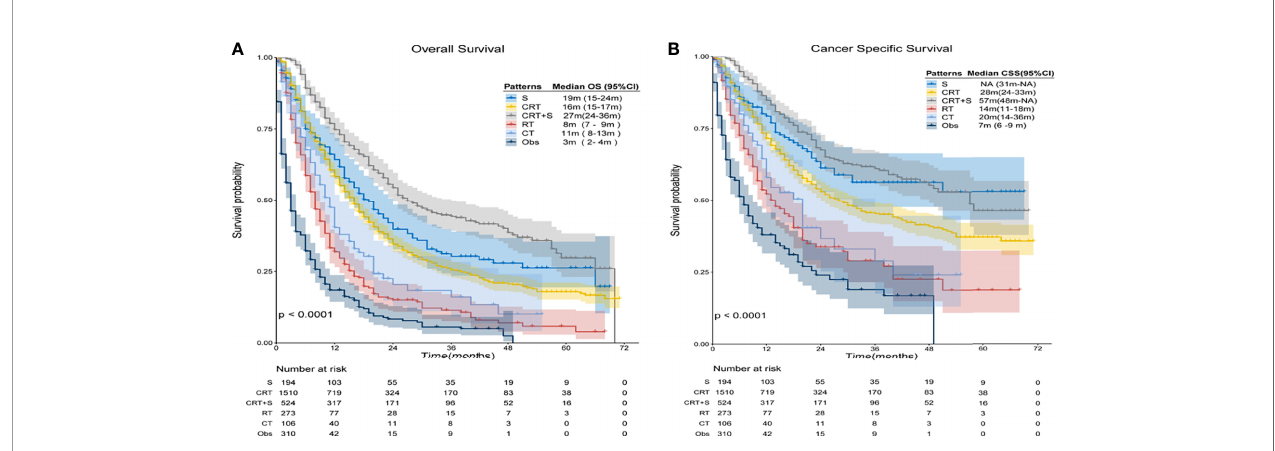
FIGURE 3 | Kaplan-Meier survival curves of OS and CSS for elderly patients with potentially curable EC. (A) Overall Survival(OS), (B) Cancer Speci fi c Survival